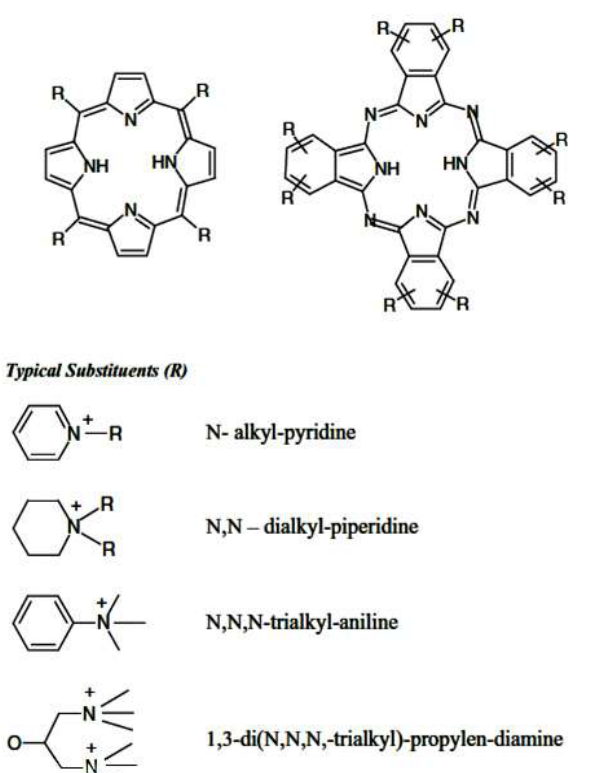
Figure 5. Structures of cationic porphyrin derivatives [46].